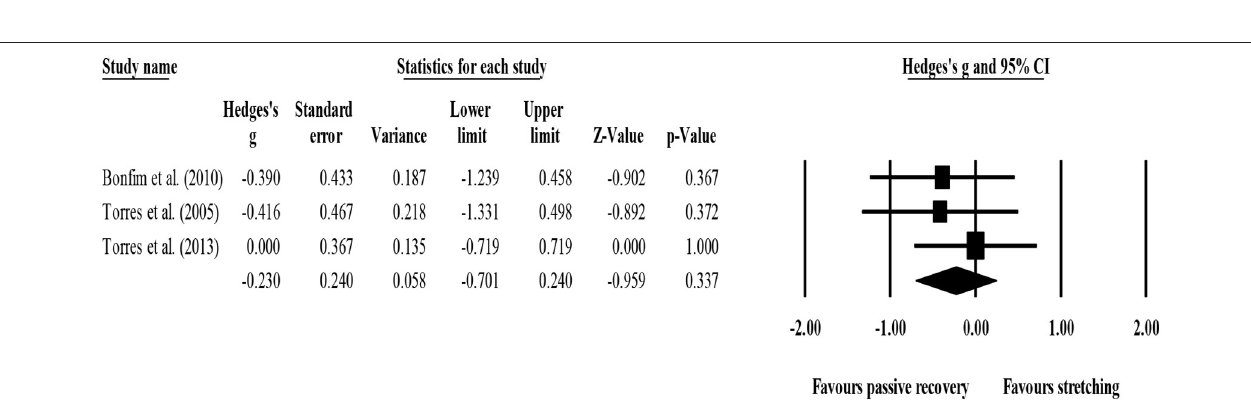
FIGURE 14 | Forest plot of changes in 72-h post-exercise delayed onset of muscle soreness (DOMS) after participating in post-exercise stretching protocols compared to control conditions (i.e., passive recovery). Values shown are effect sizes (Hedges’s g) with 95% confidence intervals (CI). The size of the plotted squares reflects the statistical weight of each study. The black diamond reflects the overall result.